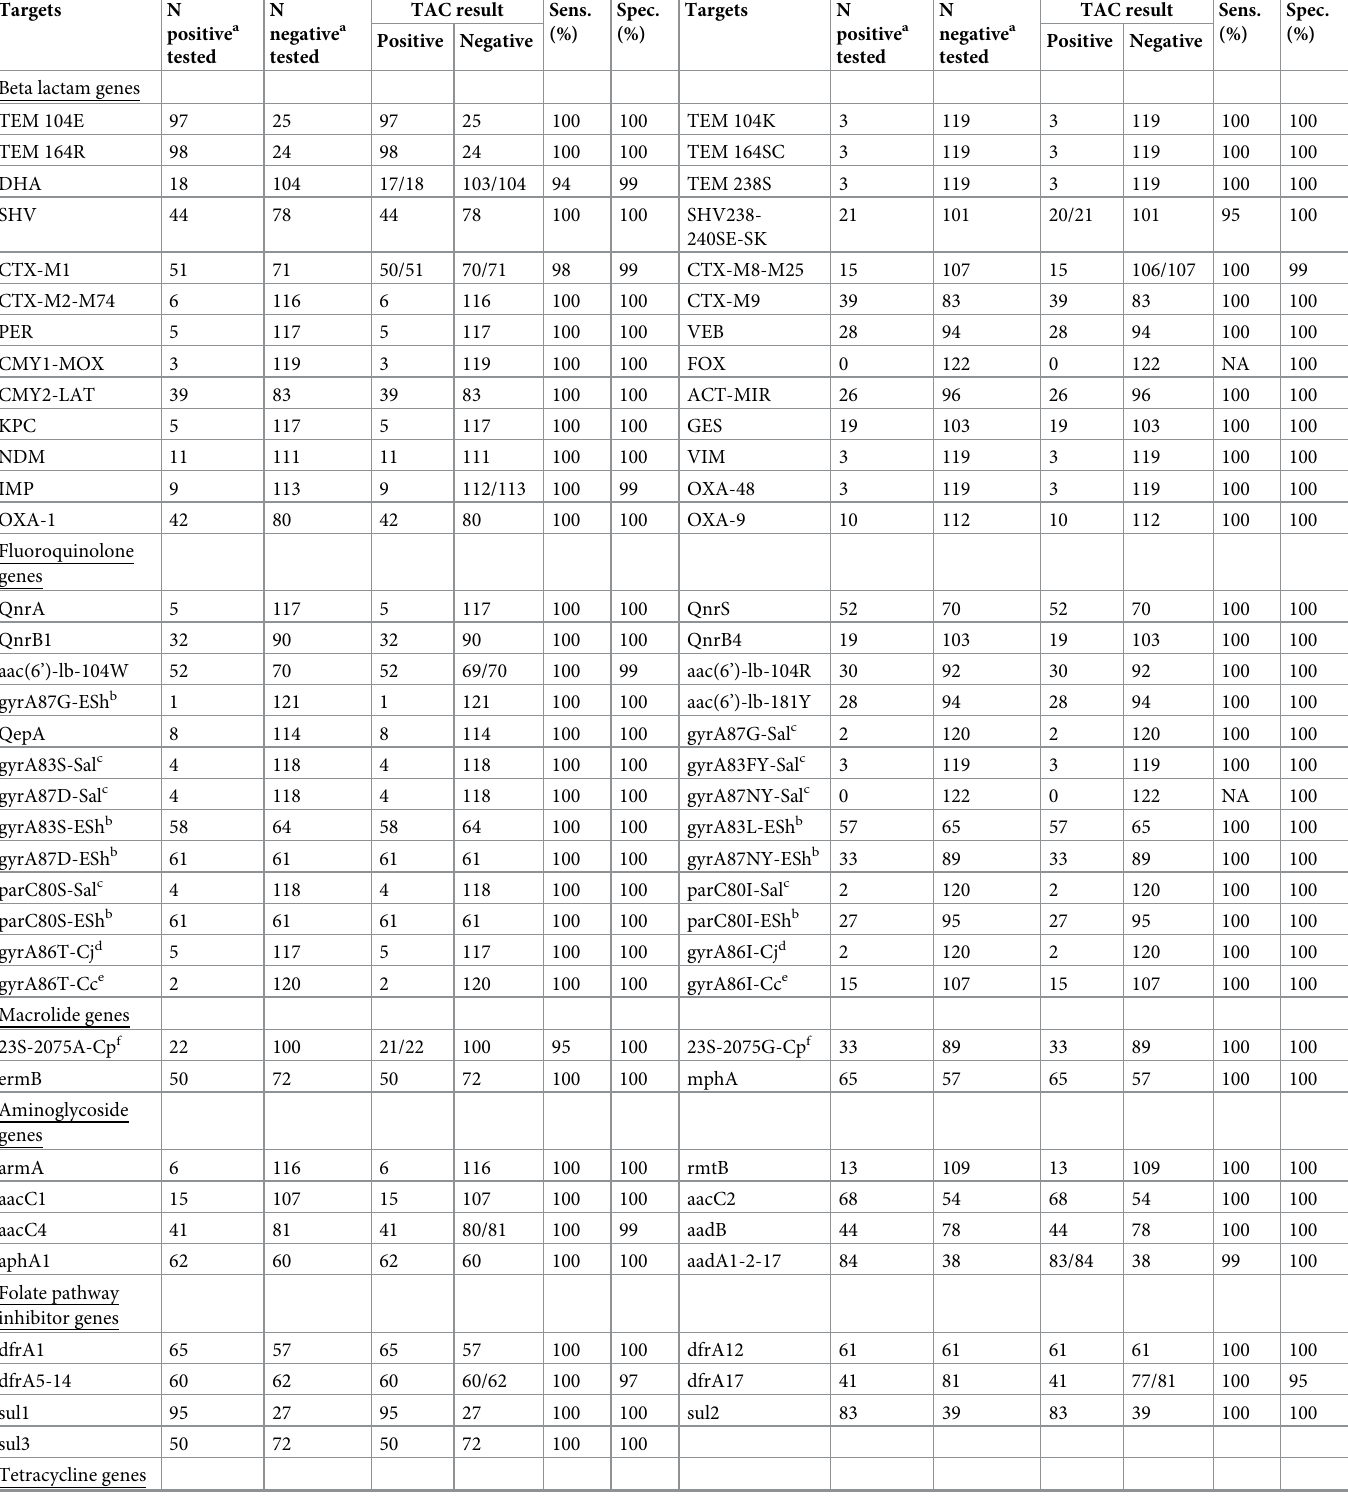
Table 4. Performance of TaqMan array card (TAC) compared with 384 well PCR plate for AMR detection in direct stool and cultured isolates (N = 122).